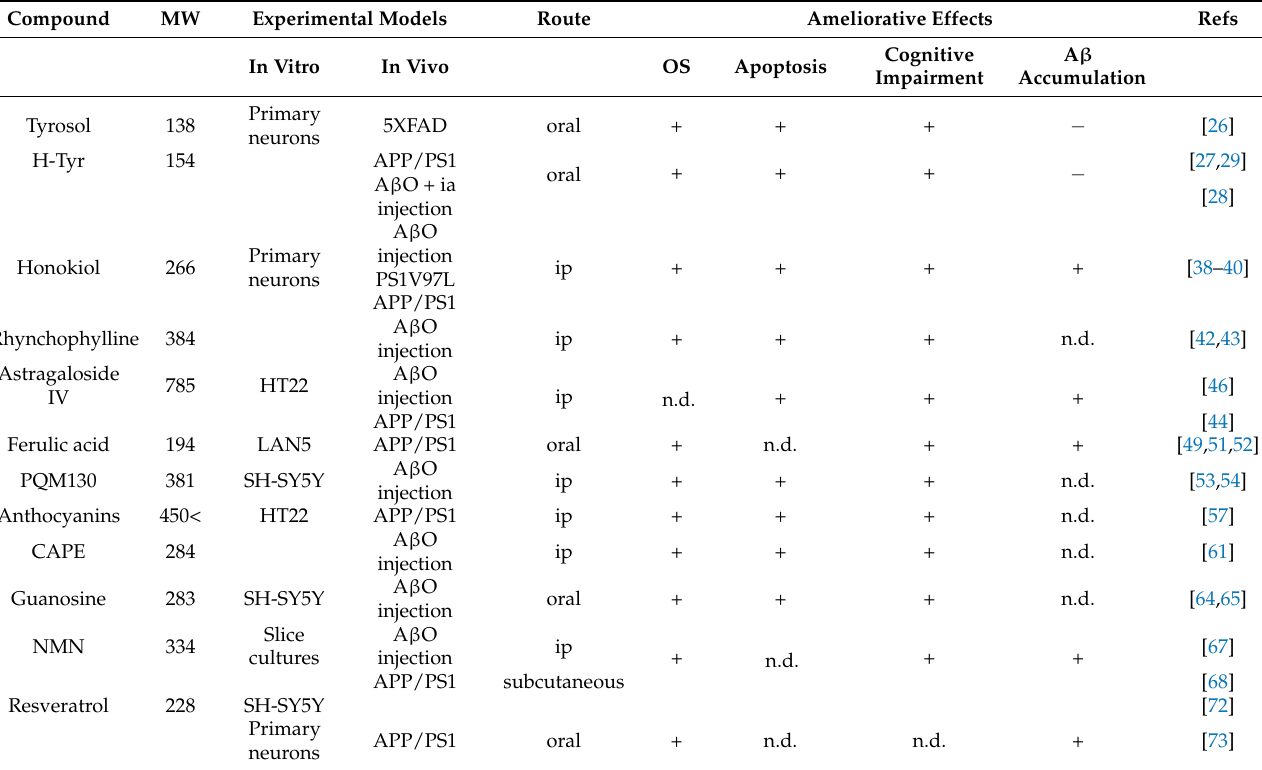
Table 1. Summary of the small molecules that can reduce A β O